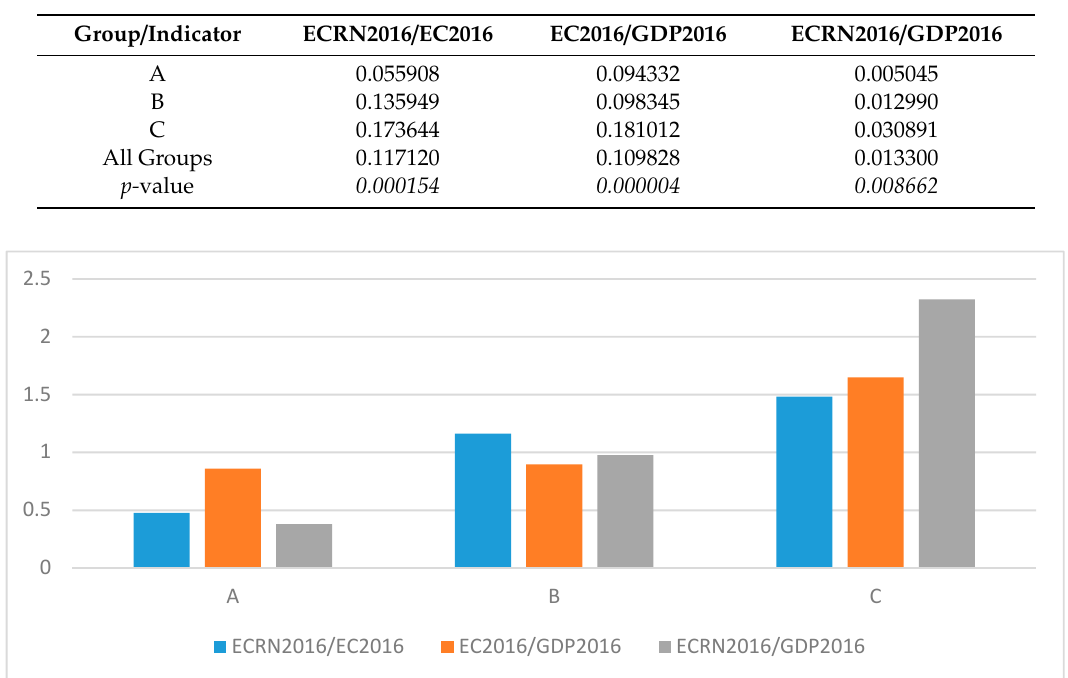
Figure 14. Comparison of group averages for IREN in 2016.